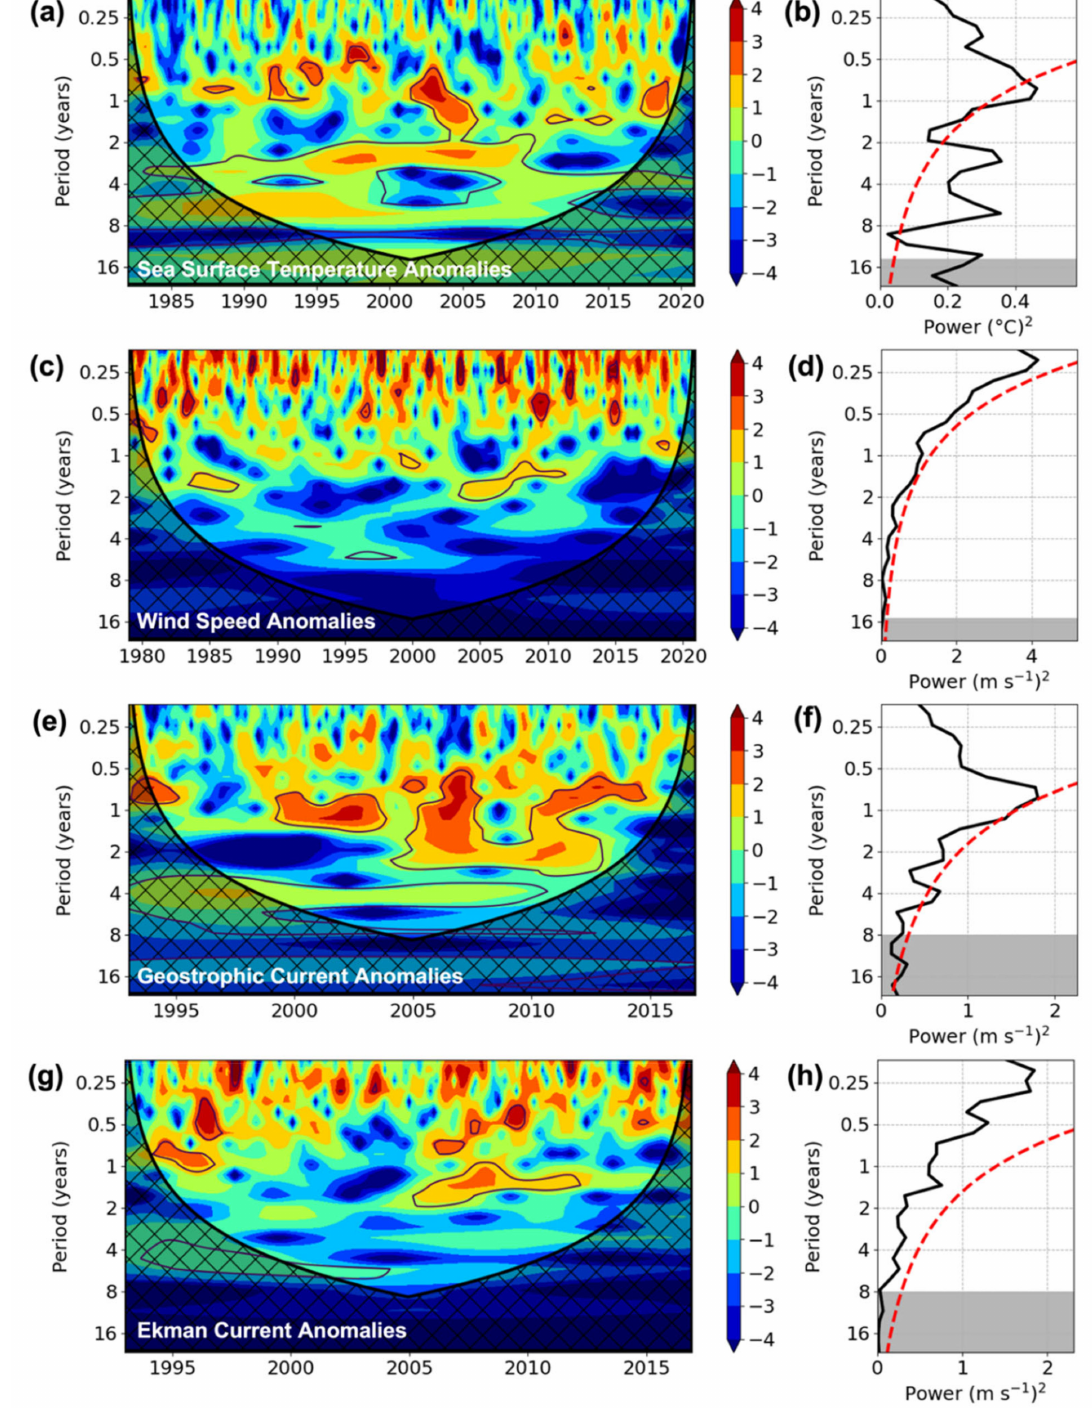
Figure 6. Wavelet power spectra of the standardized monthly anomalies of ( a , b ) Sea Surface Temper- ature (SST), ( c , d ) Wind speed, ( e , f ) Geostrophic current speed and ( g , h ) Ekman current speed. The 95% confidence level regions are highlighted in red and circled by a black contour. The cross-hatched regions are considered insignificant due to the effect of zero padding. The dashed red lines on the global wavelet spectra (on the right) represent the 95% confidence level, and the grey shaded regions are insignificant due to zero